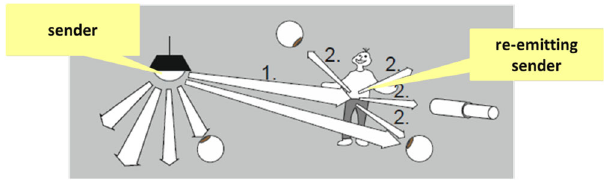
FIG. 8. Categorization of visible objects as sender (primary light source) or reemitting sender (secondary light source) [94].